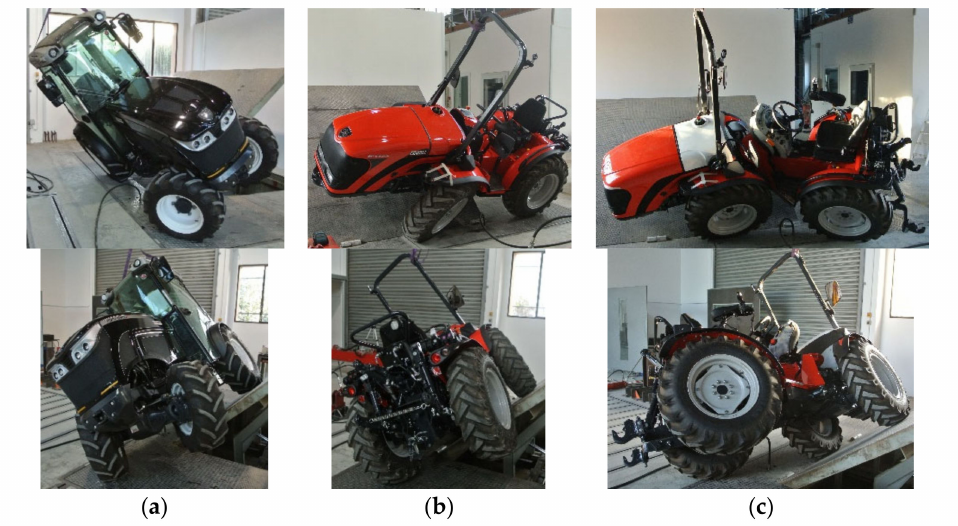
Figure 1. Preliminary analysis of the narrow-track tractors: ( a ) steering wheel tractor with a fixed chassis; ( b ) compact steering wheel tractor; ( c ) compact articulated tractor.